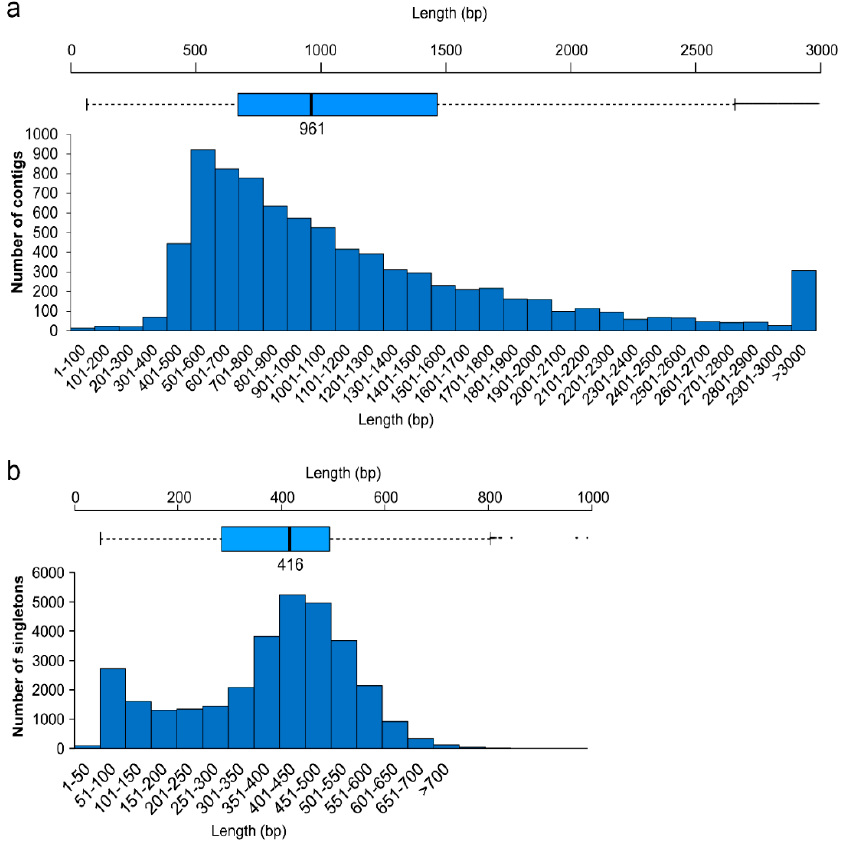
Figure 1. Distribution of M. enterolobii assembled reads. ( a ) Distribution of contigs of M. enterolobii contigs in different size ranges; ( b ) distribution of singletons of M. enterolobii in different size ranges.